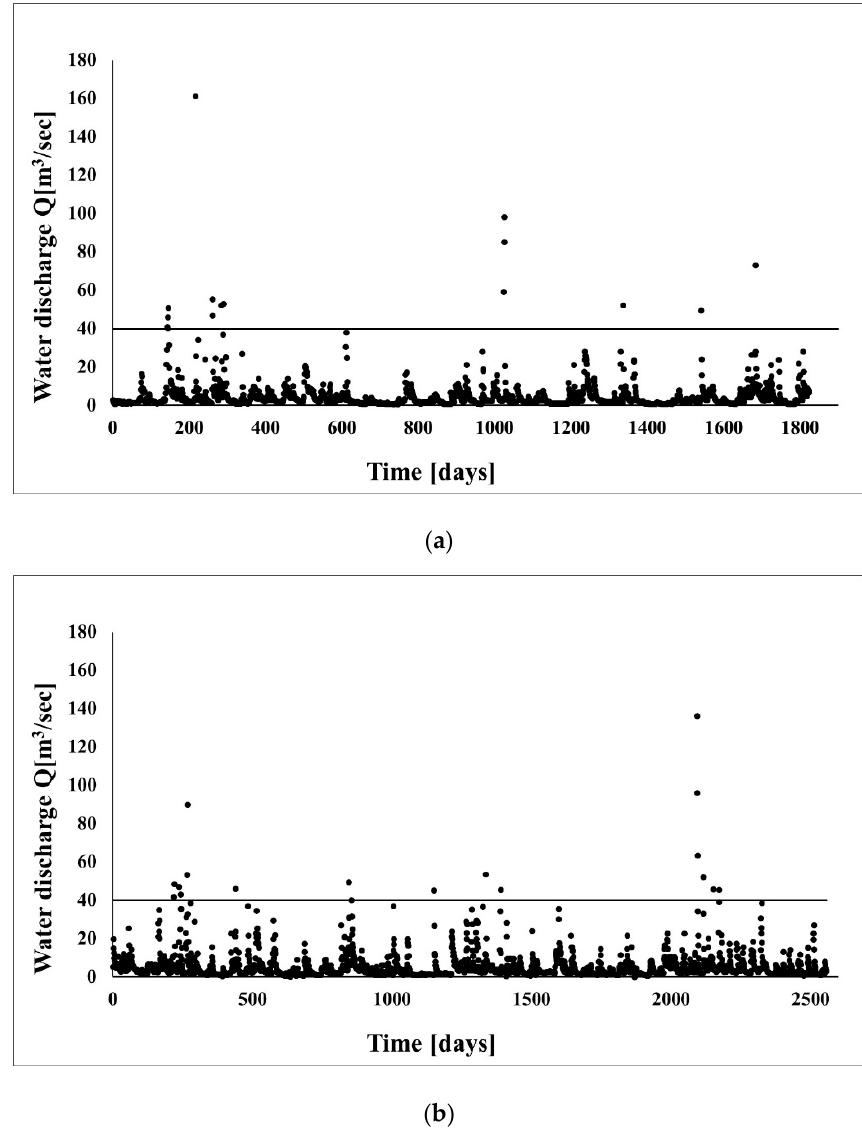
Figure 6. Water discharge levels for the Lososina river with the threshold line (the beginning of motion for the sediment) above which the bed-load transport was calculated before ( a ) and after ( b ) the river-training works performed in 1975. The horizontal lines are showing the discharge value above which bedload transport occurs.